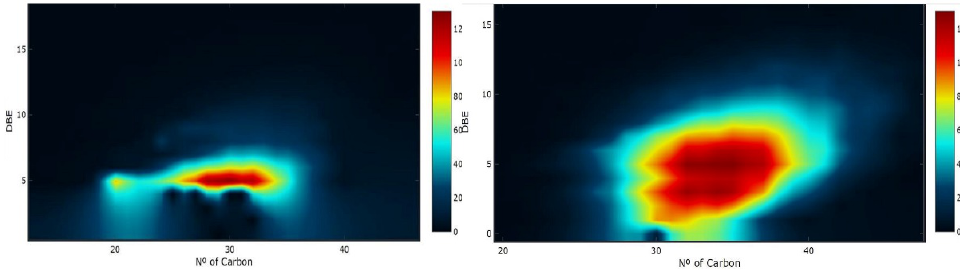
Figure 5. Isoabundance-contoured DBE versus carbon number images for S 1 class compounds detected using methylation by CH 3 I/AgBF 4 ( left panel ) and ethylation by poly(diethyl)siloxane ( right panel ).